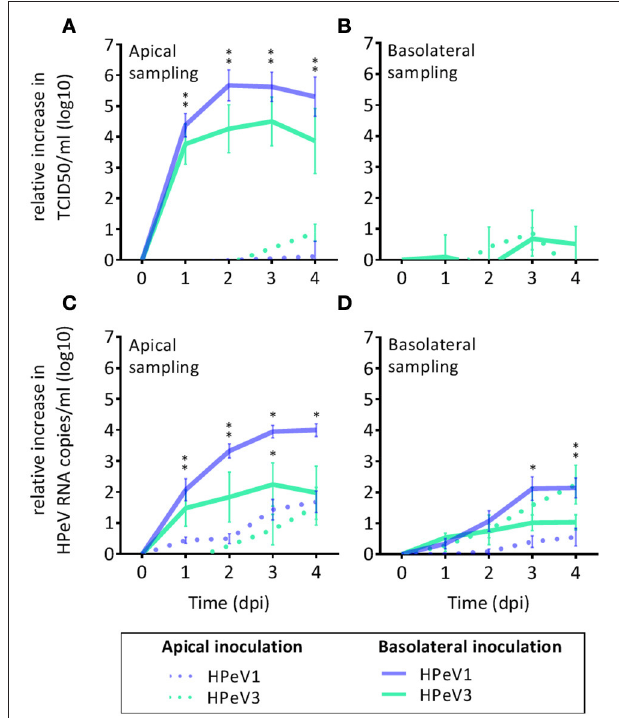
FIGURE 1 | HPeV1 and HPeV3 replication kinetics in nasal HAE cell cultures. Relative increase in HPeV 50% tissue culture infectious dose (TCID50) titers in the apical (A) and basolateral (B) HAE samples, and relative increase in the HPeV RNA copies determined by RT-qPCR analysis in the apical (C) and basolateral (D) samples following either apical (dotted line) or basolateral inoculation (solid line) of the HAE cultures. Data represents the mean and standard error of mean for four technical and four biological replicates. * p -values < 4e-4. Dpi; days post infection.